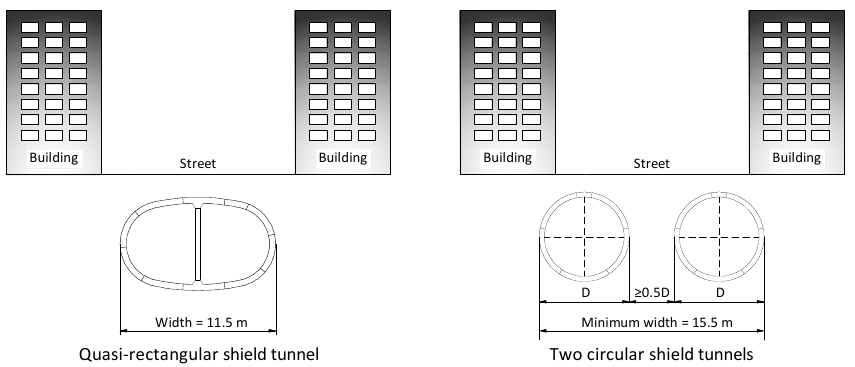
Figure 2. Comparison of a quasi-rectangular double-track shield tunnel and two circular single-track shield tunnels.